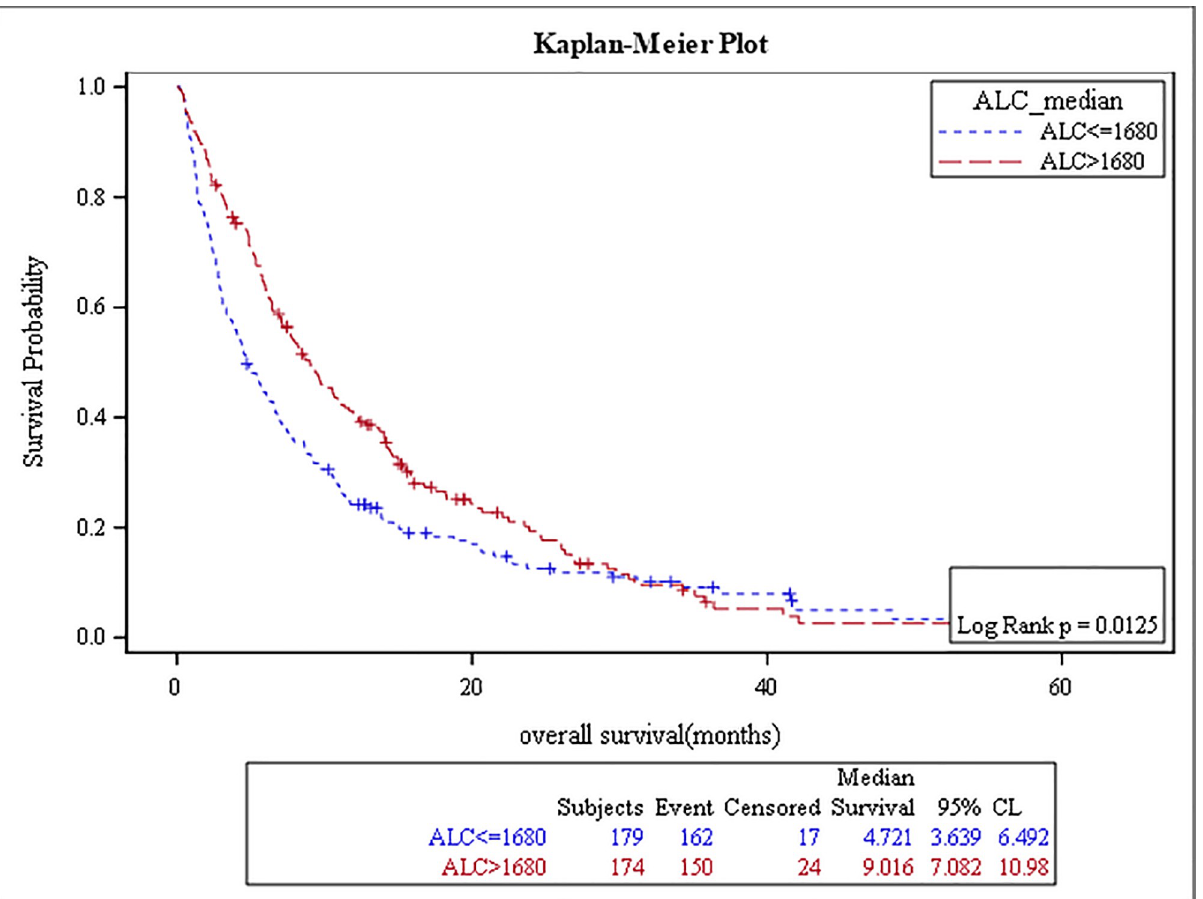
Fig 2. Kaplan Meier curve for overall survival for patients with ALC � 1680.